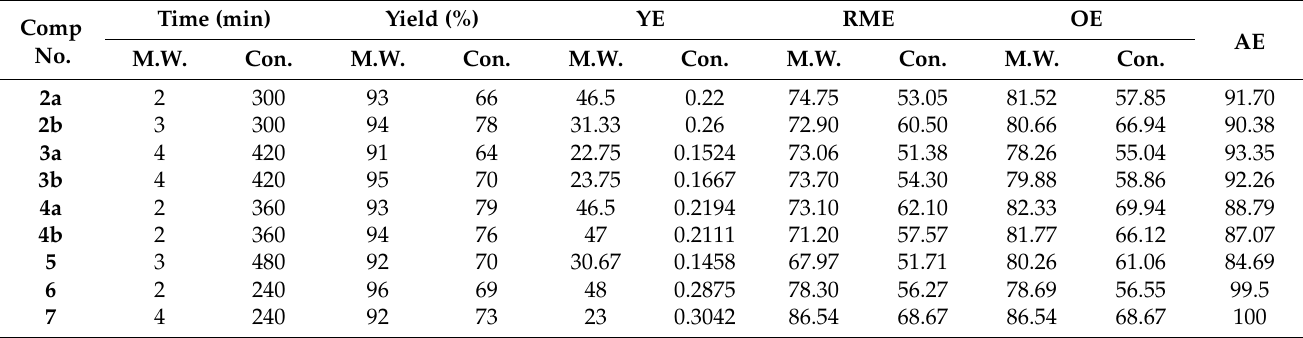
Table 1. Comparison in terms of physical data between the desired compounds ( 2a–7 ) under mi- crowave and conventional